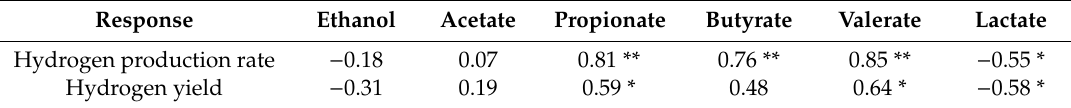
Table 6. Pearson correlation coe ffi cients between liquid metabolites and